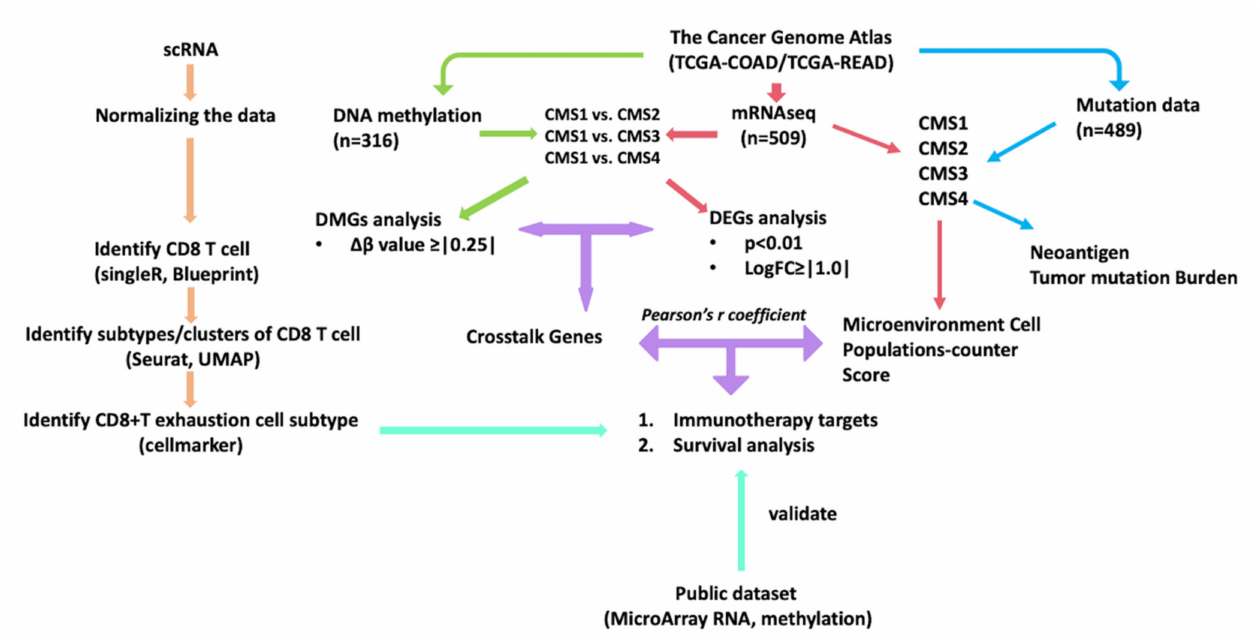
Figure 1. An outline of the methods and organization of this study. This flowchart describes the multi-omics we included and the process of how we breakdown patients by CMS classification. We then compared CMS1 and other CMS subtypes to determine DEGs and DMGs. Then, the MCPcounter score was calculated and survival analysis was undertaken using the identified CD8+ T exhaustion cell maker and immuno-crosstalk gene. Pathway associations were determined for DEGs using the Reactome online browser. Tumor mutation burden and neoantigen were used to evaluate the CMS subtypes. Eleven publicly available datasets were used to validate our partial results. scRNA, single-cell RNA-Seq; DMG, differentially methylated gene; DEG, differentially expressed